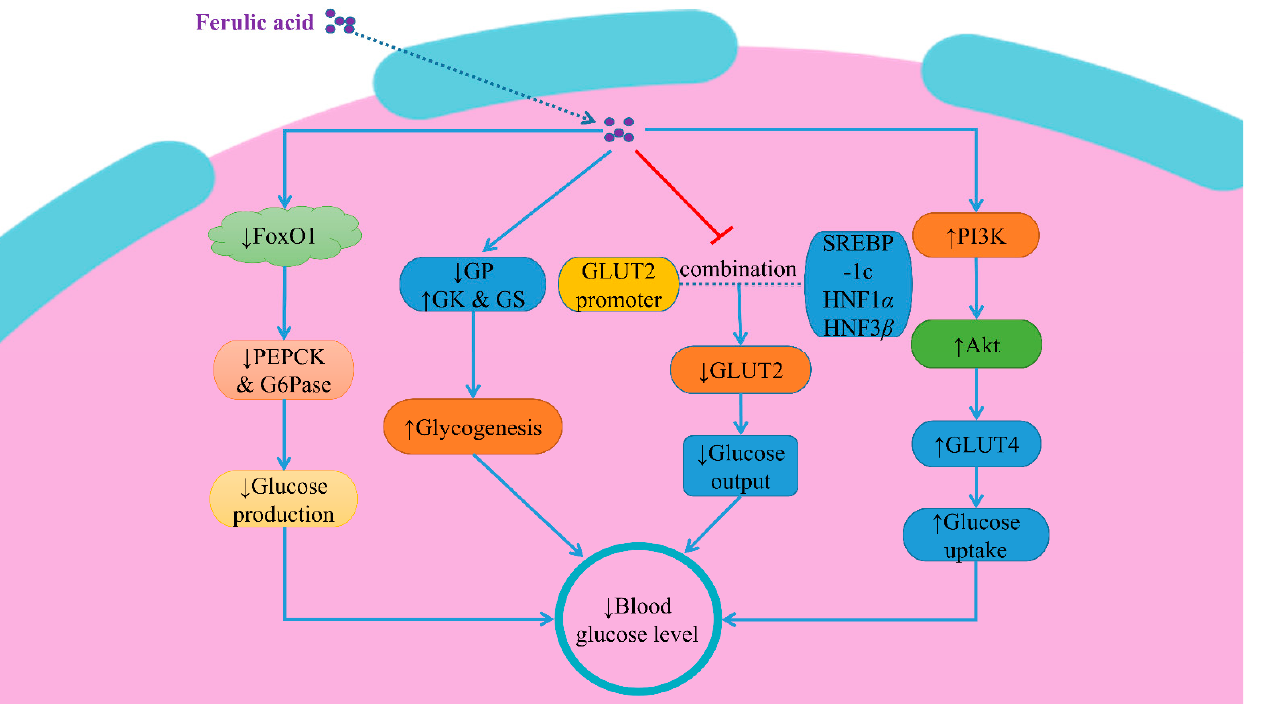
Figure 2. The molecular mechanisms of ferulic acid in improving type 2 diabetes. Note: ↑ : acti- vate/upregulate; ↓ : inhibit/downregulate; PI3K: phosphatidylinositol 3-kinase; Akt: phosphory- lated-protein kinase B; PEPCK: Phosphoenolpyruvate carboxylase; G6Pase: glucose-6-phosphatase; GP: glycogen phosphorylase; GK: glucokinase; GS: glycogen synthase; SREBP1c: sterol regulatory element-binding protein-1c; HNF: hepatocyte nuclear factor.